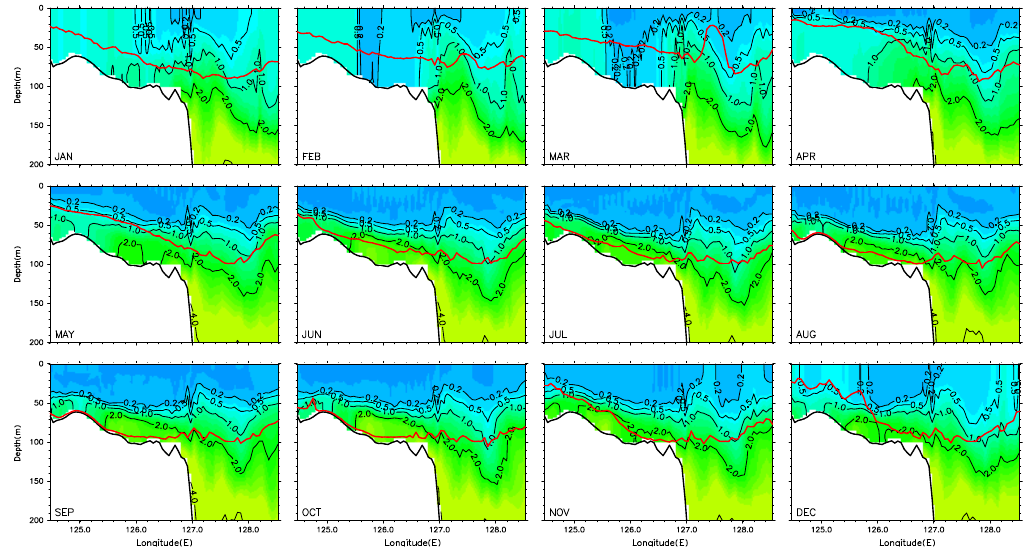
Fig. 15. The anomaly of monthly DIN (mmolm − 3 ) along the PN line between the sensitivity experiment, in which the oceanic nutrients are enriched by 30%, and the control experiment. Red lines denote euphotic